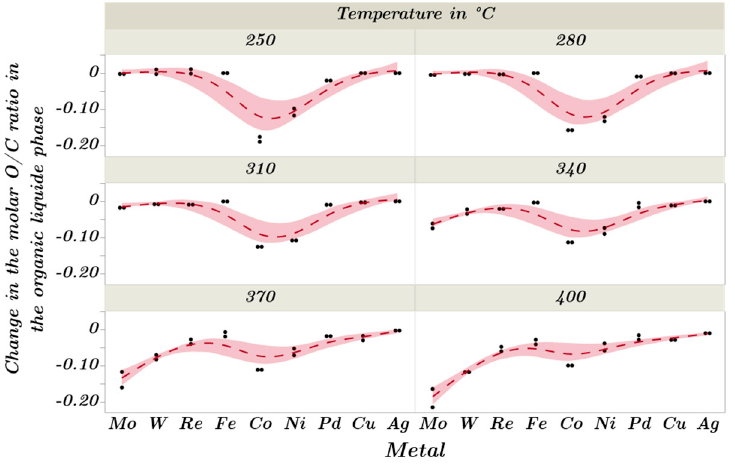
Figure 14. Change in the molar O/C ratio in the liquid phase compared to the starting material guaiacol (O/C = 0.29). A negative change results from a decrease in the O/C ratio, i.e., deoxygenation. The dashed smoothing is based on a spline with λ = 0.05 and the confidence interval is shown as an envelope curve.